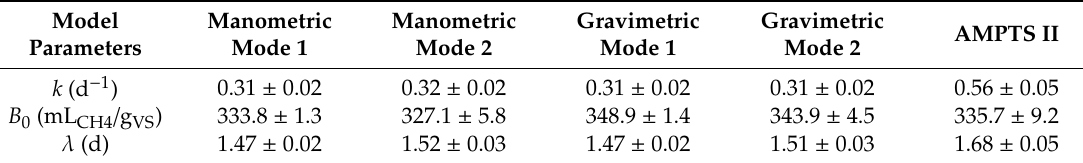
Table4. Fittedmodelparametersforeachmethod: B 0 isthemaximummethaneproduction(mL CH4 / g VS ), k is the first-order decay constant k (d − 1 ), and λ is the lag phase (d). Values are means ± standard deviation ( n = 3 for AMPTS II, otherwise n =